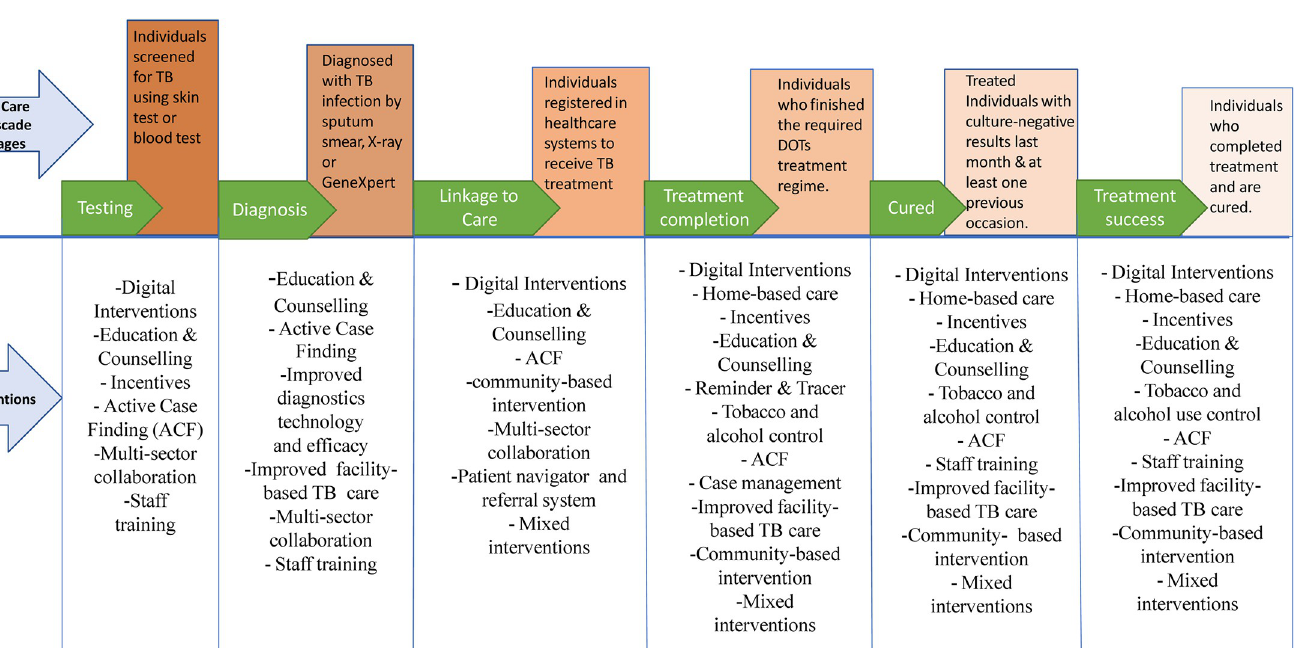
PLOS Medicine| https://doi.org/10.1371/journal.pmed.1004091 January 3,